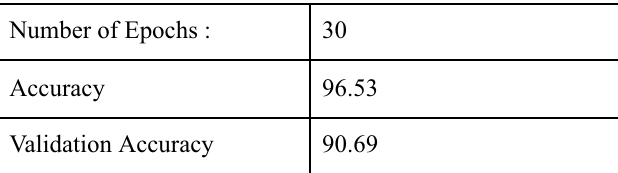
Table 1: Training details of Seq2Seq Model with Attention Number of Epochs